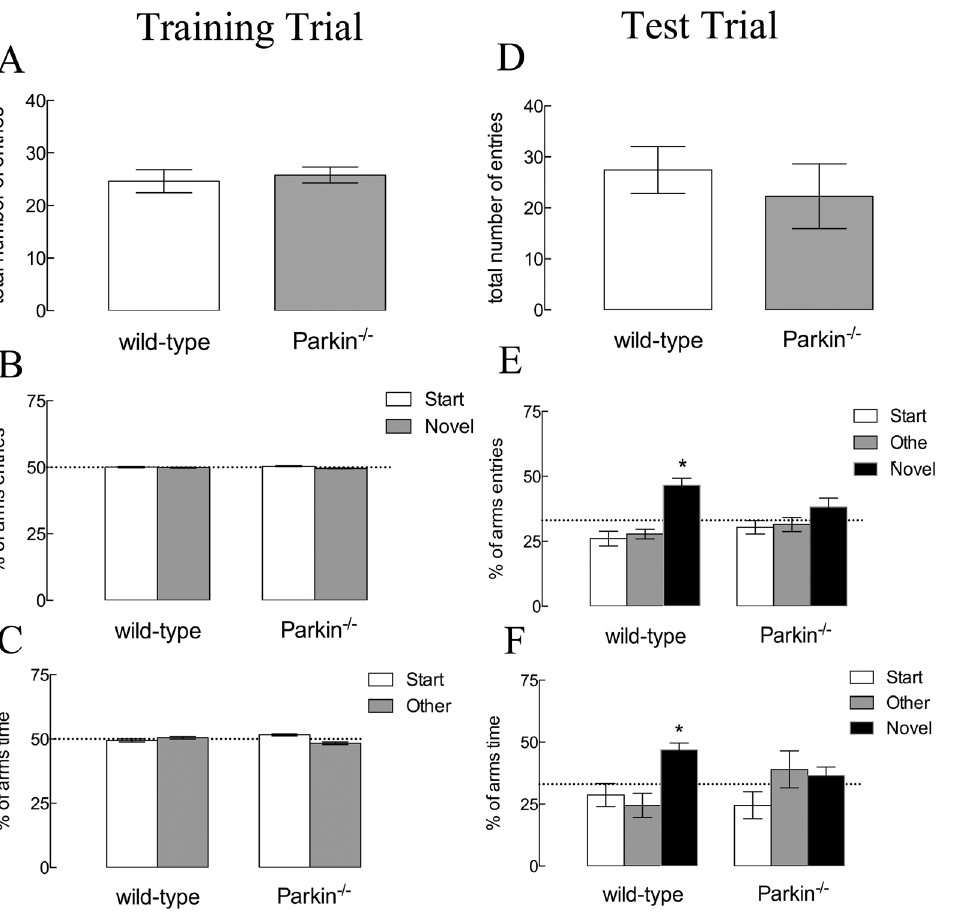
Figure3.Effectsof parkin genetic deletiononspatialrecognitionmemory performance. (AandD)Totalnumberofentriesduringthetrainingandthetest sessions (respectively) by wild-type and parkin 2 / 2 mice. (B and E) Percentage of arms’ entries during the training and test sessions (respectively); *P , 0.05 compared to the hypothetical value of 33% (random entries). (C and F) Percentage of time spent in each arm during the training and test sessions (respectively) by wild-type and parkin 2 / 2 mice; *P , 0.05 compared to the hypothetical value of 33% (random time). Data are mean ¡ s.e.m. of n 5 9–10 per